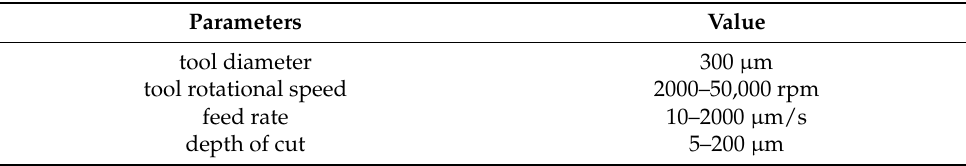
Table 2. The grinding parameters for the fused